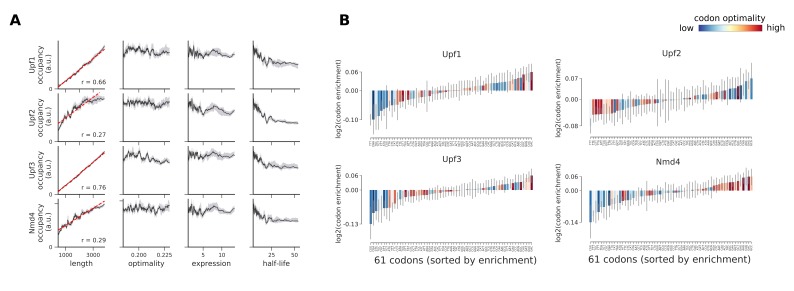
Occupancies for components of the NMD pathway (Upf1, Upf2, Upf3, and Nmd4) compared to transcript length, optimality, expression level, and half-life.(A) To understand binding specificity of factors in the NMD pathway, the total occupancy of each factor on a transcript is plotted against various transcript features (Gray shading: 95% confidence intervals generated by bootstrapping transcripts). (B) Same analysis as in Figure 6B: Codon enrichment shows deviations in codon frequencies of transcripts bound by a degradation factor compared to each codon’s frequency on all coding sequences. Each bar is colored according to its codon-optimality with highly optimal codons in dark red and highly non-optimal codons in dark blue. (Gray lines: 90% confidence intervals generated by bootstrapping coding sequences).